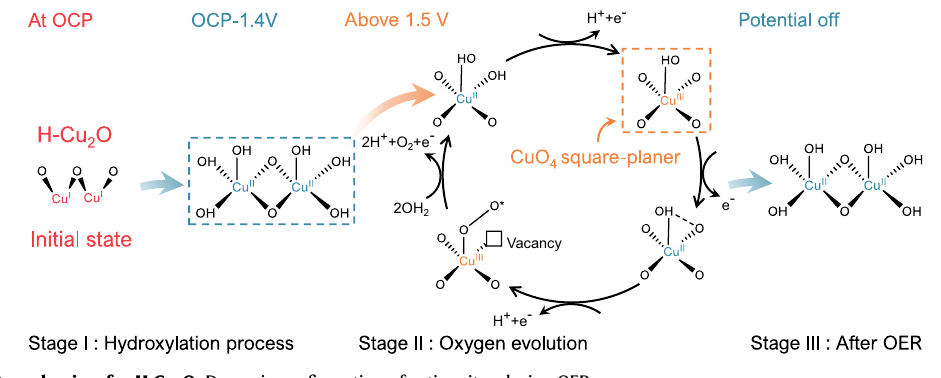
Fig. 5 | Proposed OER mechanism for H-Cu 2 O. Dynamic con fi guration of active sites during